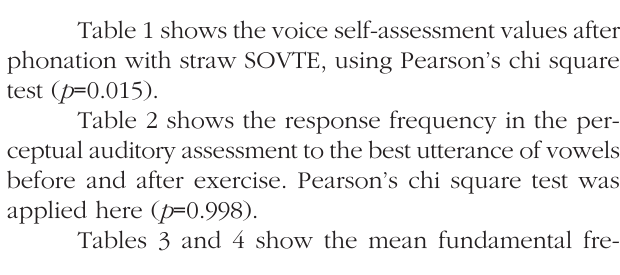
reach the statistical